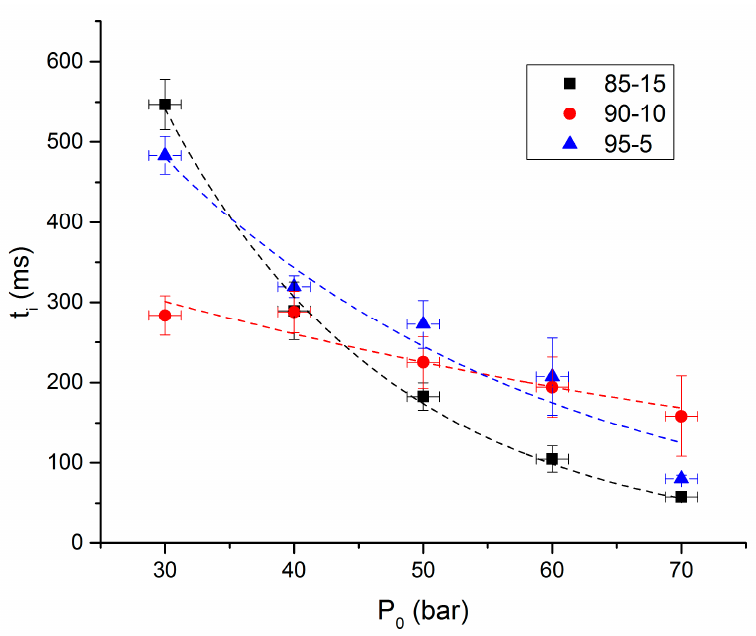
Figure 7. Ignition delays as functions of initial pressures under argon.